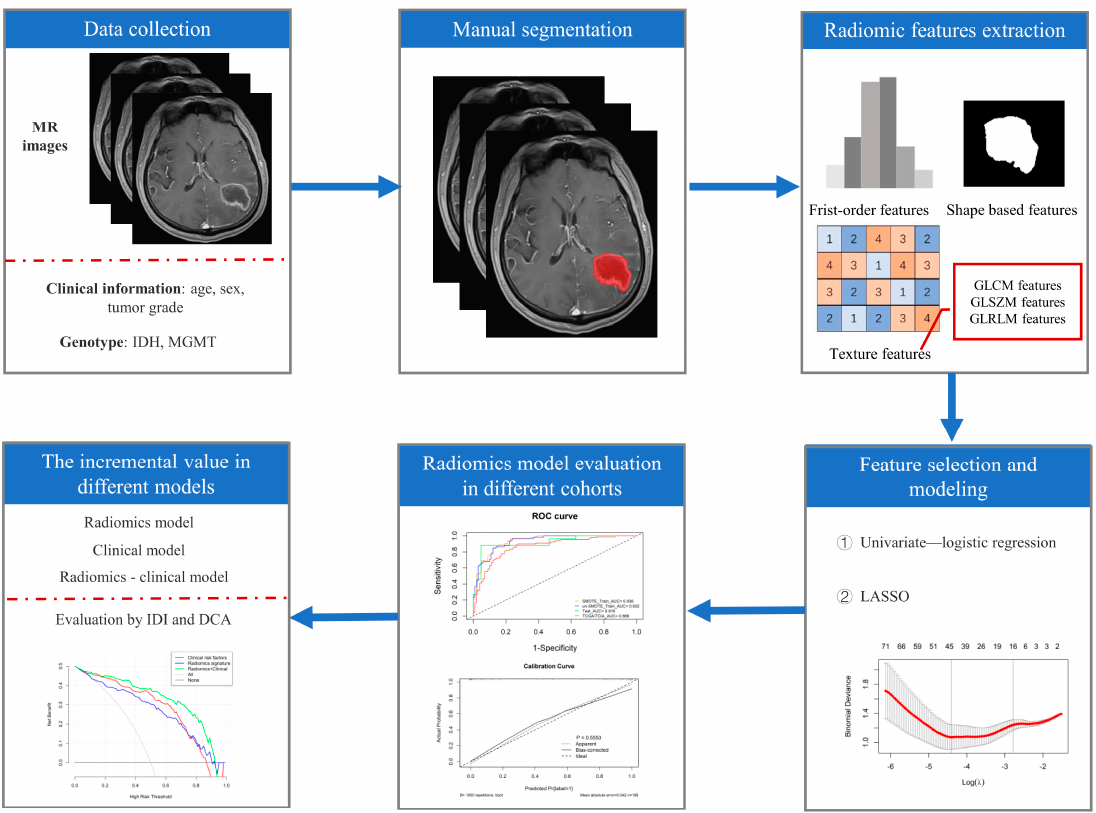
Figure 1. Radiomics pipeline. Note: LASSO (least absolute shrinkage and selection operator), IDI (integrated discrimination improvement index) and DCA (decision curve analysis).